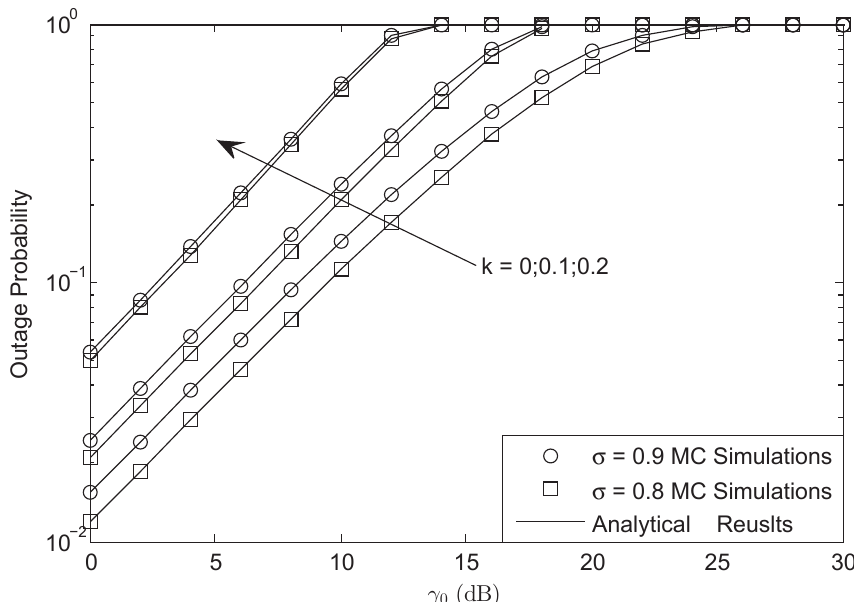
Figure 4. OP of the system versus different γ 0 with M = 3, γ = 30 dB and L = 10: FHS.